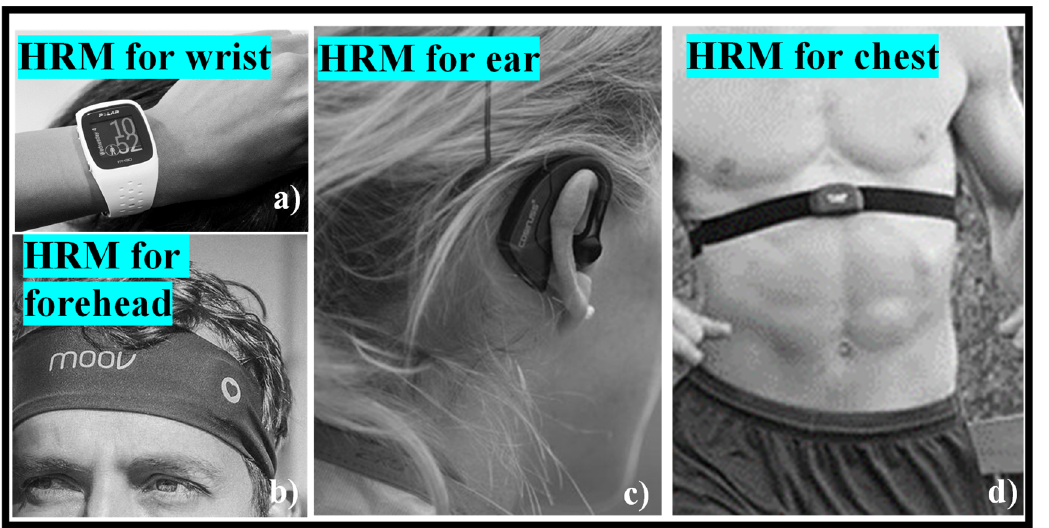
Figure 7. Commercially available HRM: ( a ) wrist [99], ( b ) forehead [100], ( c ) ear [101], ( d ) chest [99].